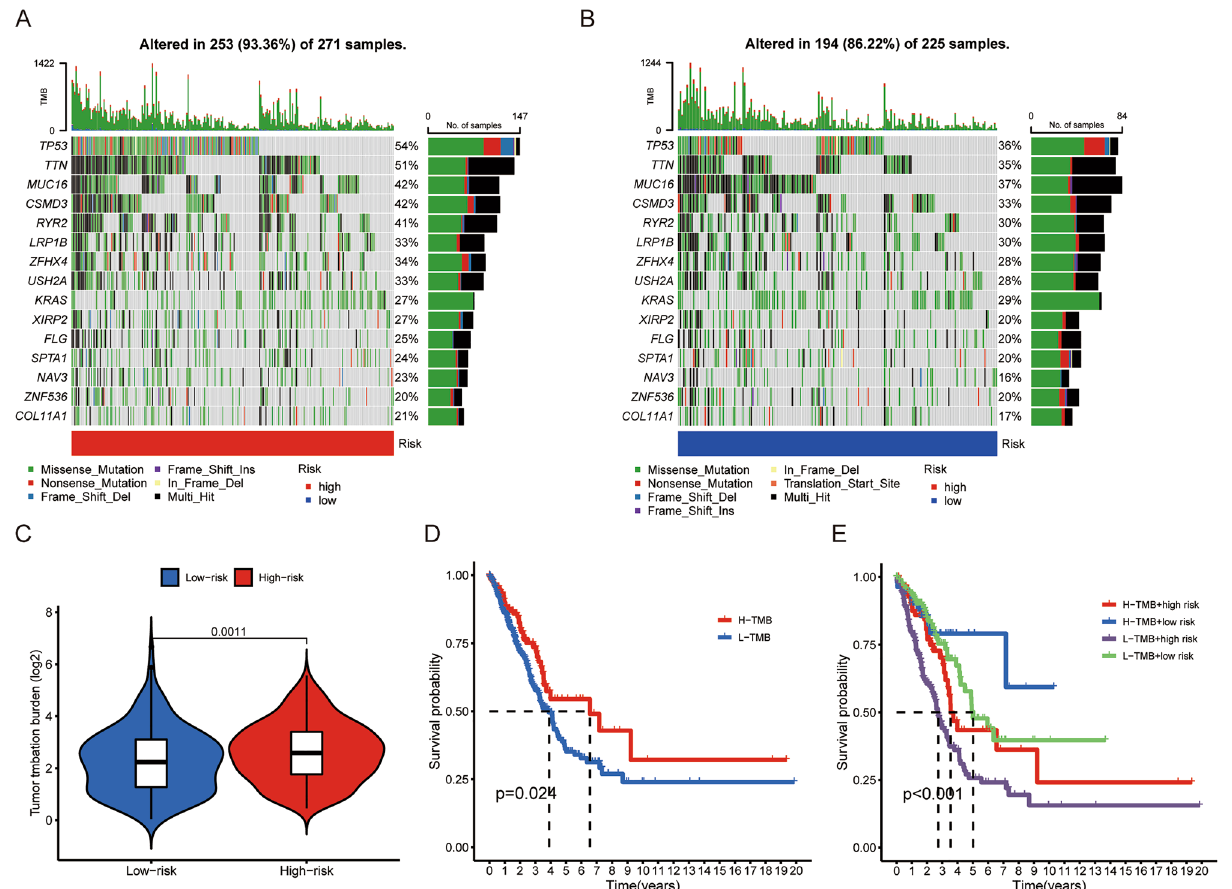
Figure 5. Correlations between the risk score and somatic variants. ( A , B ) The mutation rates of top 15 genes in high- and low-risk groups. ( C ) Tumor mutation burden between high- and low-risk groups. ( D )